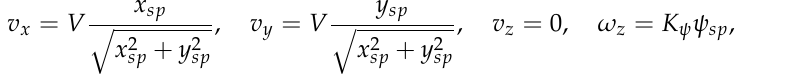
gray arrows, the target curve is represented by the black curve, and trees are represented by cylinders. The cylinders were painted in yellow and red to facilitate the correspondence with the actual trees in the snapshots ( a – f ), which were also painted with the same colors. The executed trajectory, obtained from the localization system of the drone, is shown in green. In this trajectory, the letters ( a – f ) correspond to the snapshots